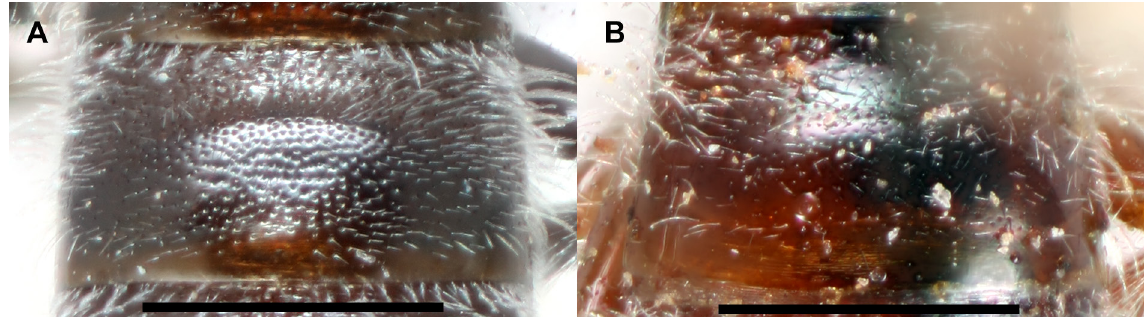
Fig. 112. T2. A . Lasioglossum pseudotegulare (Cockerell, 1896), ♂, punctures nearly touching in centre. B . L. stictaspis (Sandhouse, 1923), ♂, punctures not close to touching. Scale bars = 0.5 mm.